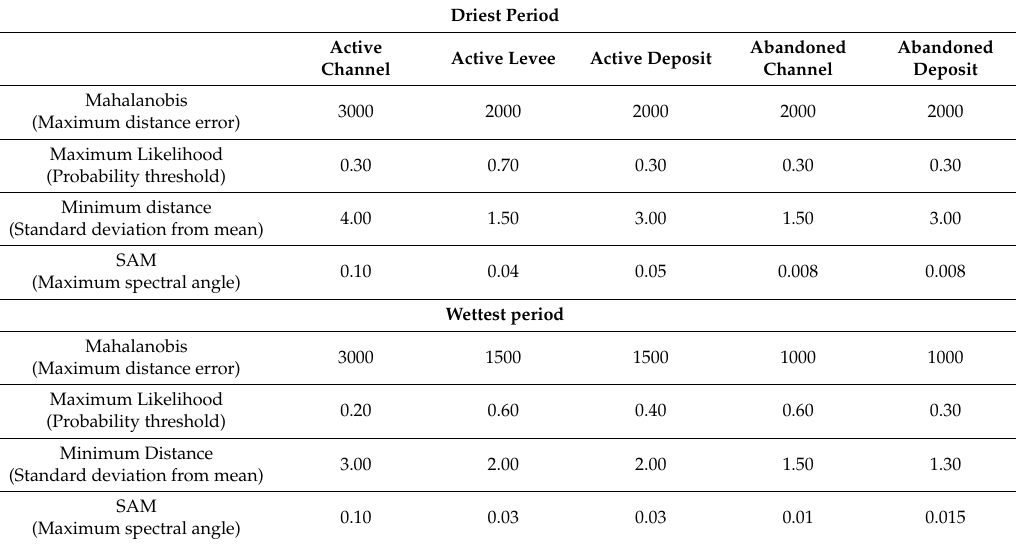
Table 1. The most accurate thresholds for each classification